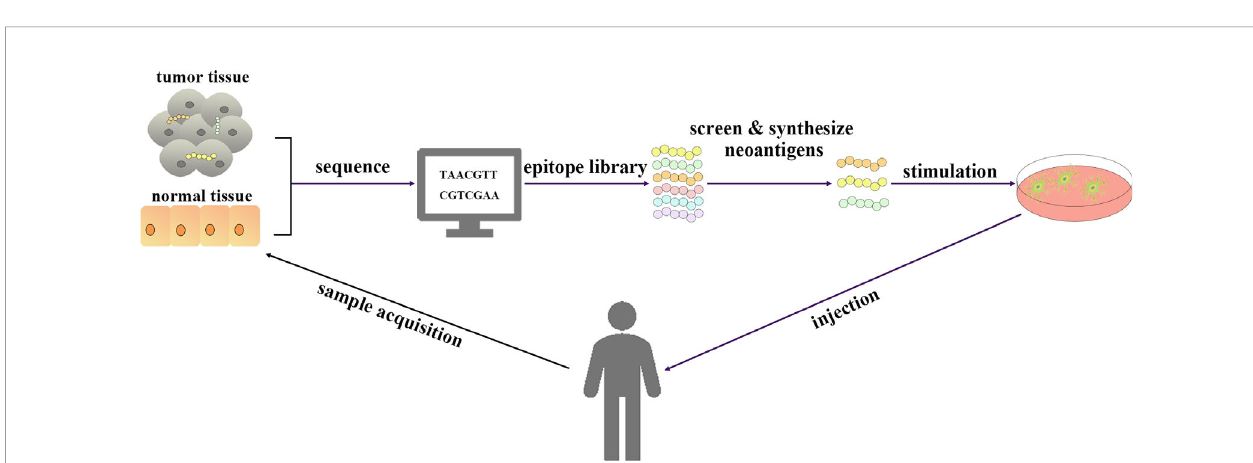
FIGURE 2 | Schematic diagram of personalized neoantigen-pulsed DC vaccines. Tumor tissue and normal tissue of patients were sequenced. The epitope library is processed by bioinformatics methods, from which immunogenic neoantigens are screened and synthesized. The DC vaccines loaded with neoantigens are prepared by using DCs extracted from the peripheral blood of patients and injected into patients.